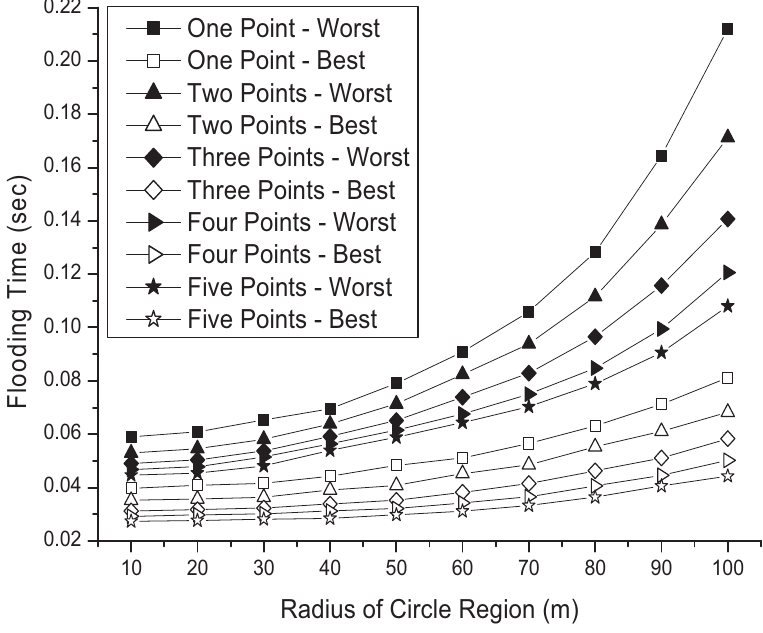
Figure 2. Flooding time for circle region with radius r